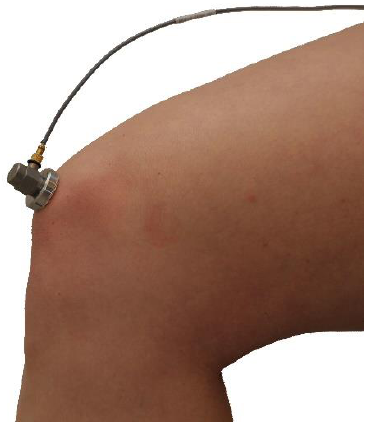
Figure 5. The accelerometer attachment: 1 cm above the apex of patella.